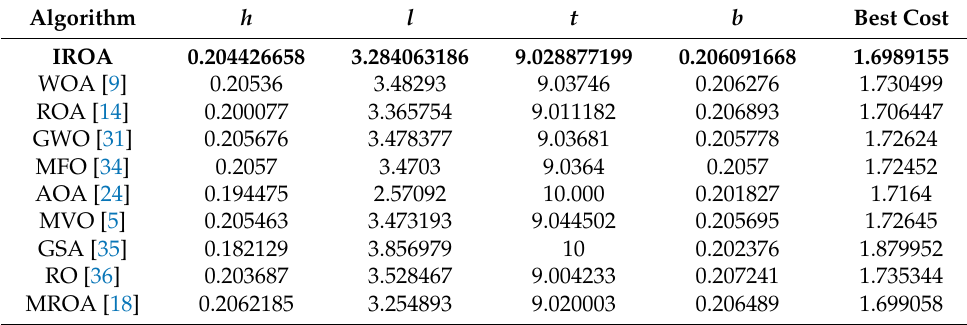
Table 9. Experimental results of welded beam